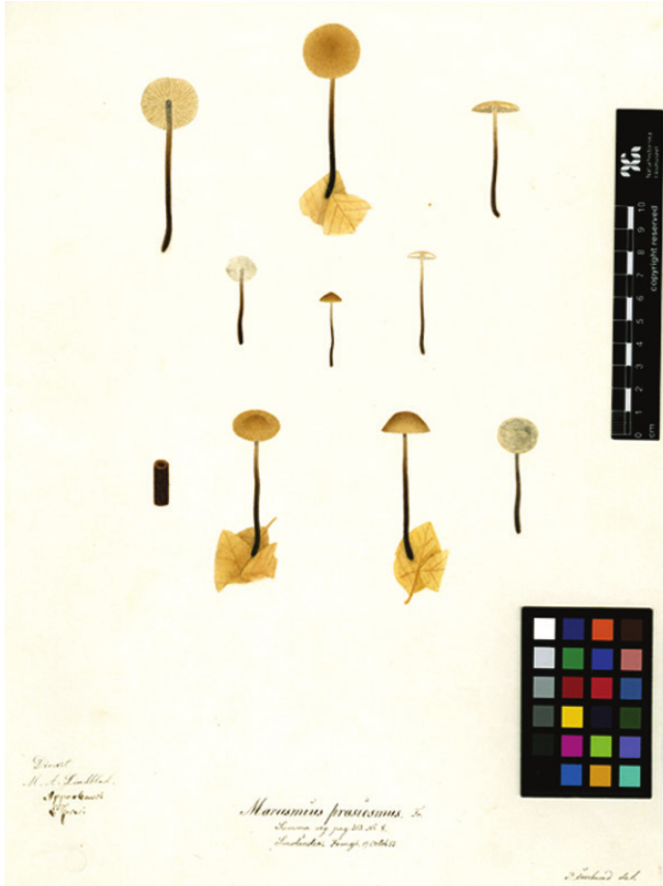
Figure 95. Aquarelle of A. prasiosmus commissioned by E.M. Froies (Courtesy